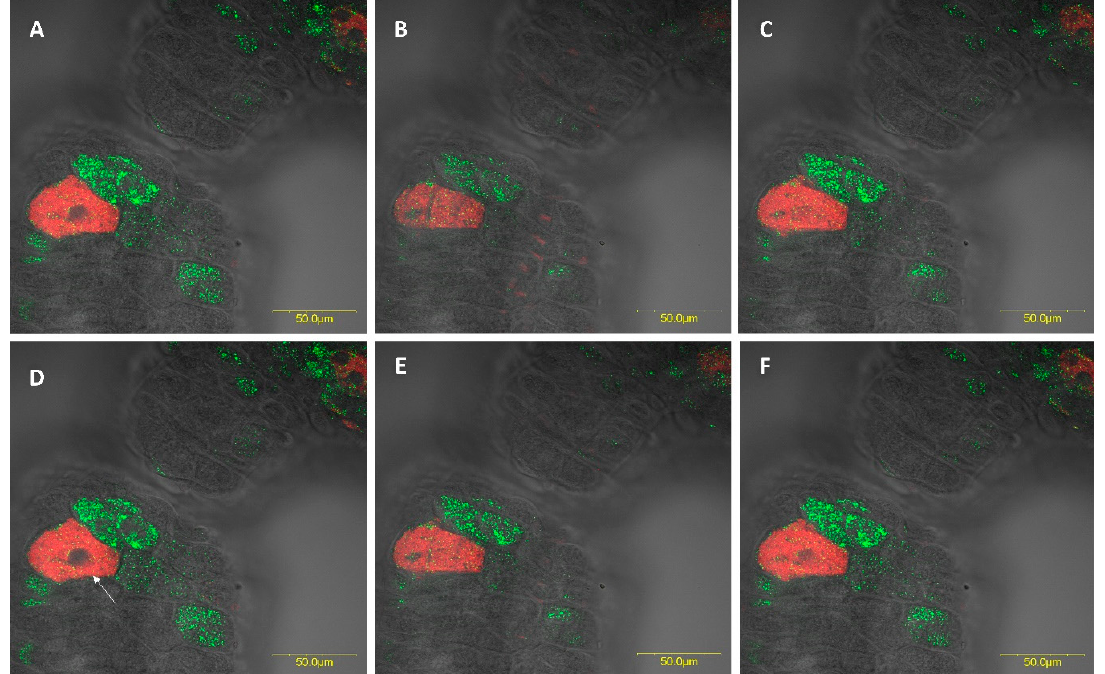
Figure 7. Z sections from part of male midgut of M. pygmaeus (circle 1 Figure 6A, B). Rickettsia bellii (red) and R. limoniae (green) can be seen to inhabit separate bacteriocytes in the gut epithelium, as well as occupying the same bacteriocyte, e.g., in Figure D (see arrow). A–F Serial Z-sections of 8.8 um (0.8 um increasement).